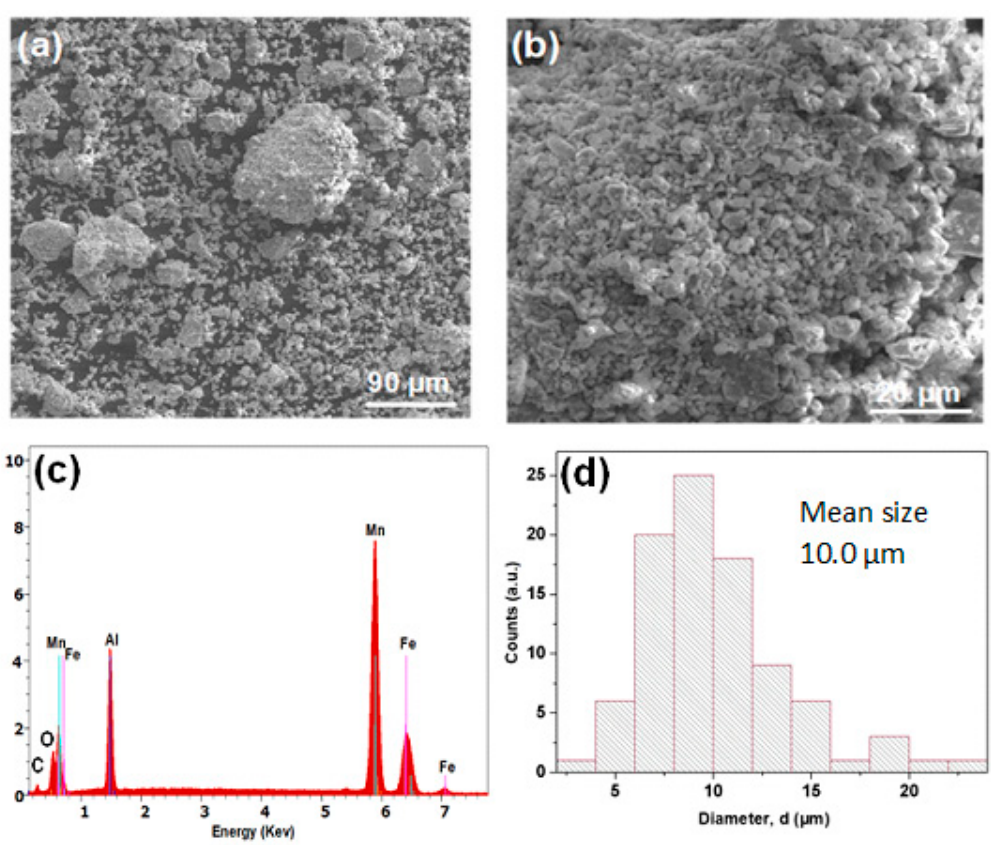
Figure 1. ( a , b ) Micrographs of the mechanical alloying (MA) Mn-Al-Fe. ( c ) Energy-dispersive X-ray spectroscopy (EDS) microanalysis and ( d ) distribution of particle sizes of the mechanically alloyed powder.